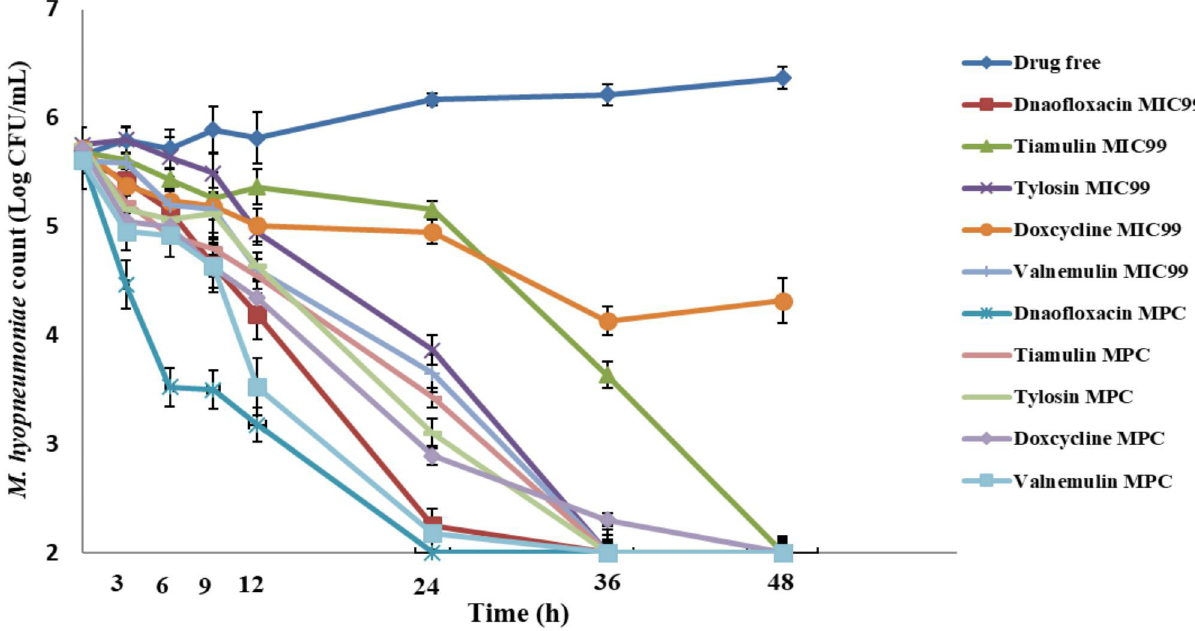
Fig 2. M . hyopneumoniae killing curves at the minimal concentration inhibiting colony formation by 99% (MIC 99 ) and at the mutant prevention concentration (MPC) with an inoculum of 10 5 CFU/mL.